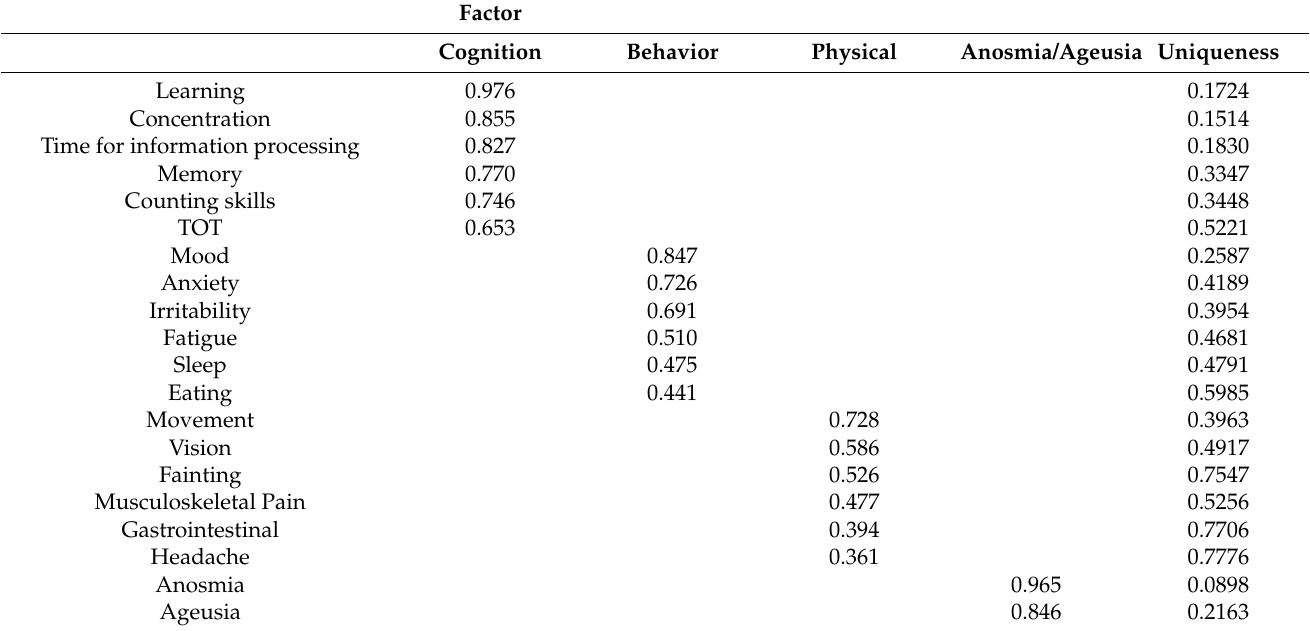
Table 4. Loading matrix of the extracted factors. Factors were extracted with the Maximum Likelihood Extraction Method in combination with “oblimin”